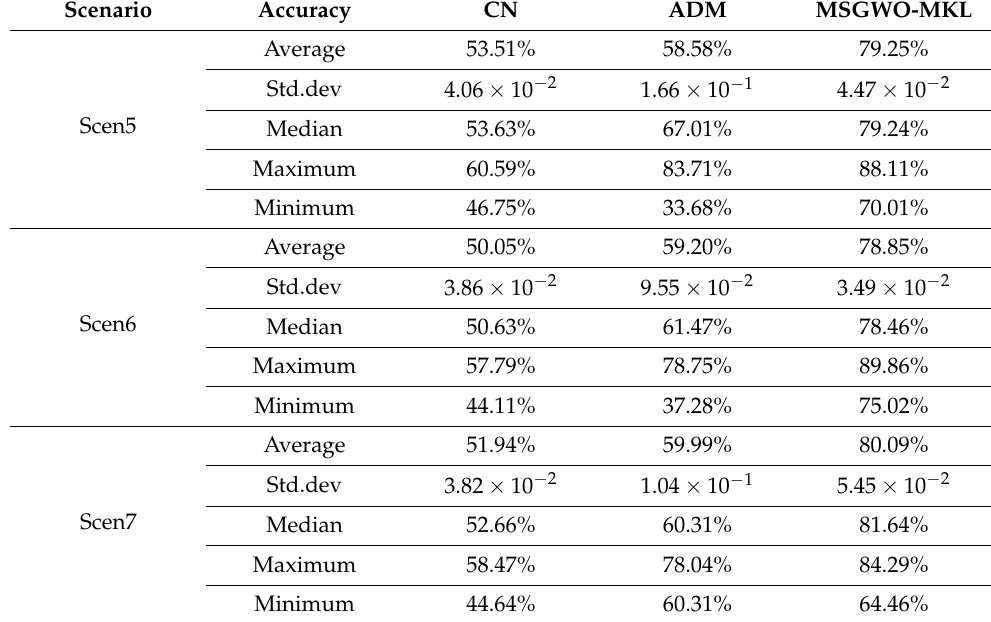
Figure 21. Variation of accuracy about time length. According to the results of Figure 20, with the scale of the UAV swarm increasing, the missing link prediction accuracy of the MSGWO-MKL-SVM algorithm showed a downward trend. This is due to the fact that, with the scale of the UAV swarm increasing, the UAV swarm network will get more and more complicated, and the difficulty of link prediction will also increase at the same time. According to the results of Figure 21, with the observation time length increasing, the missing link prediction accuracy of the MSGWO-MKL-SVM algorithm showed an upward trend and then a downward trend. This is due to the fact that, with the observation time length increasing, the information in the time series is increasing, and the difficulty of link prediction will also decrease at the same time. However, a UAV swarm is a dynamic, time- varying, complex network. If the observation time is too long, the UAV swarm network will undergo many changes, resulting in part of the time series data being invalid. 7. Discussion This paper proposed a new algorithm, MSGWO-MKL-SVM, based on time series to solve the MLP problems of UAV swarm networks. In Section 6, the multi-objective opti- mization ability of the MSGWO algorithm, the classification ability of the MSGWO-MKL algorithm, and the missing links predicting ability of the MSGWO-MKL-SVM algorithm